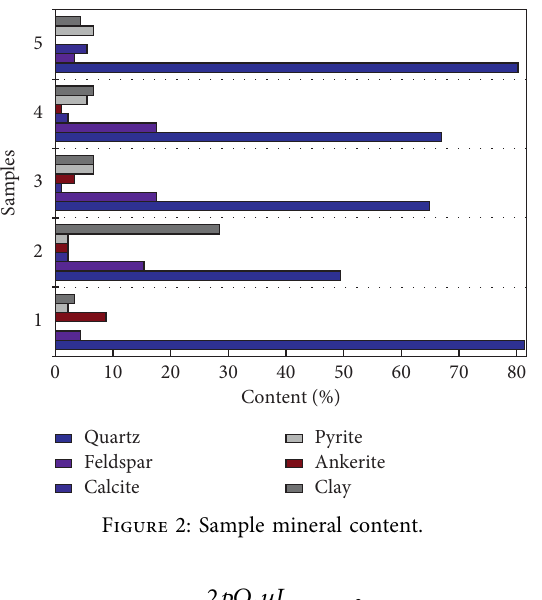
Figure 2: Sample mineral content.